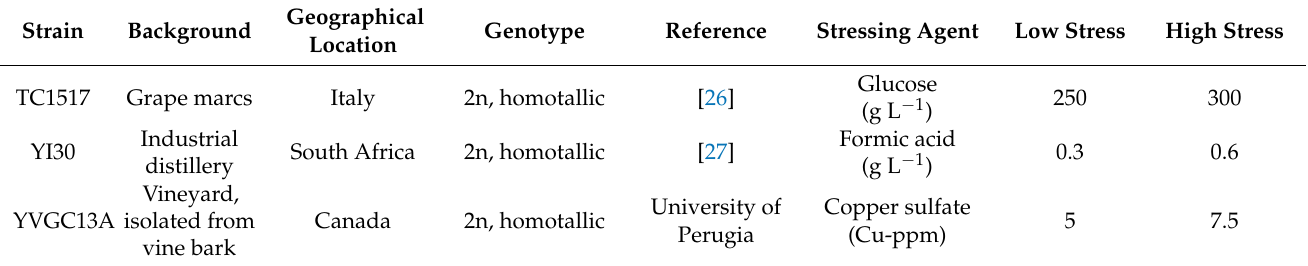
Table 1. Strains used in this study: background, origin and tested stressing